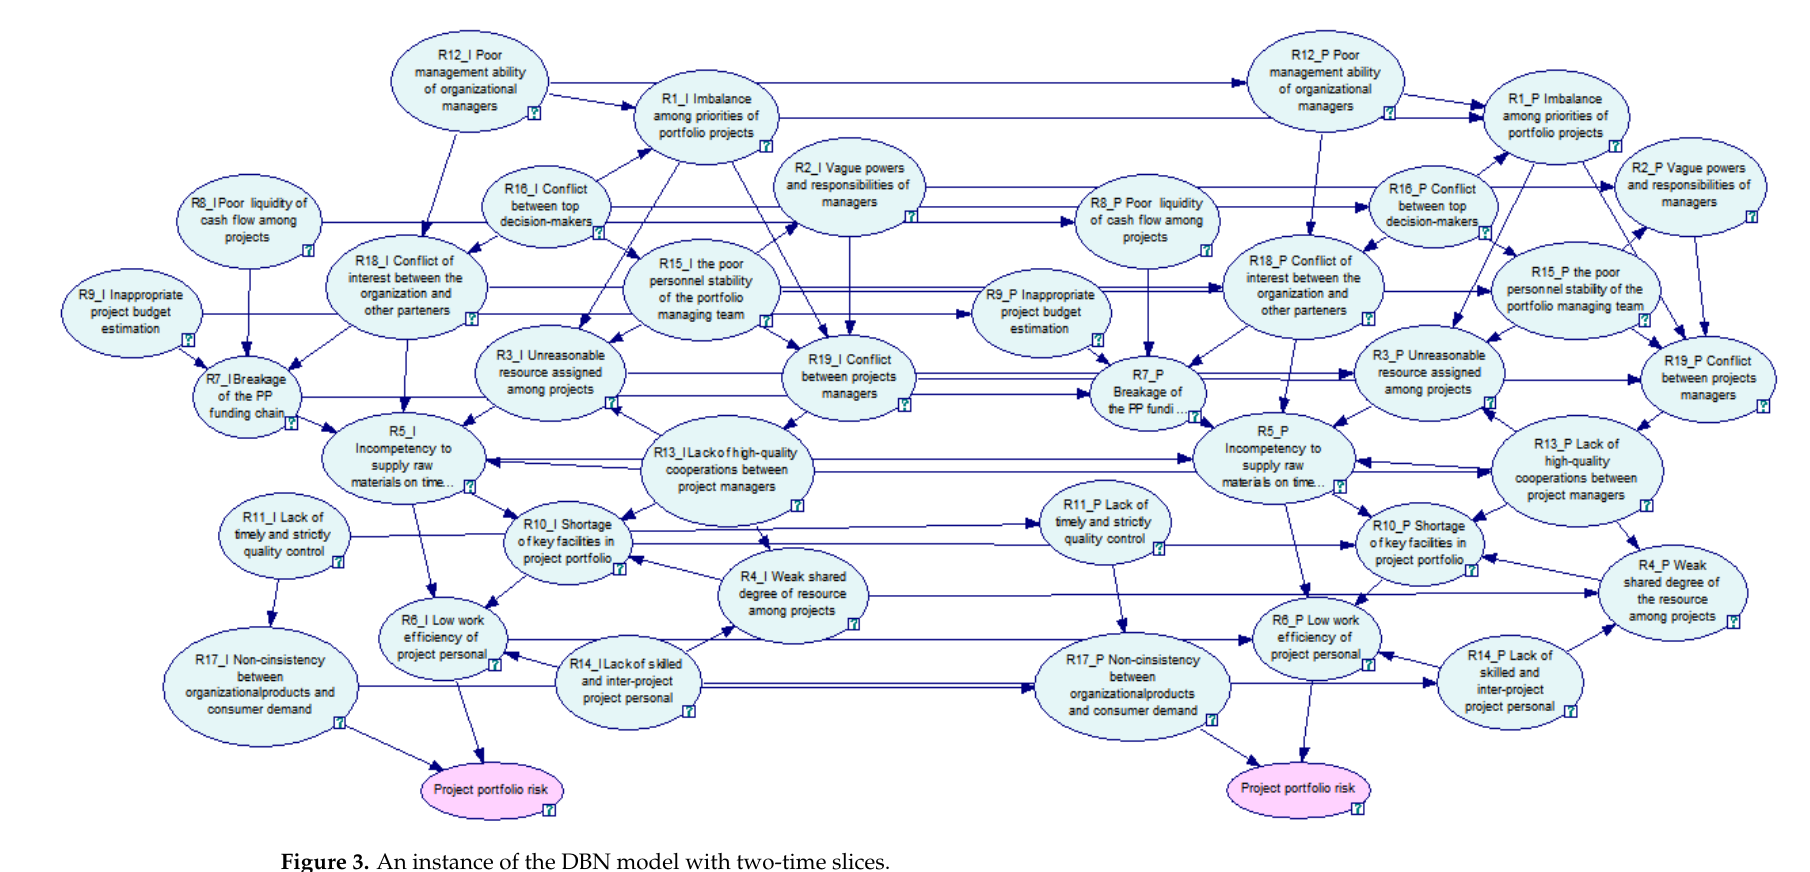
Figure 3. An instance of the DBN model with two-time slices.